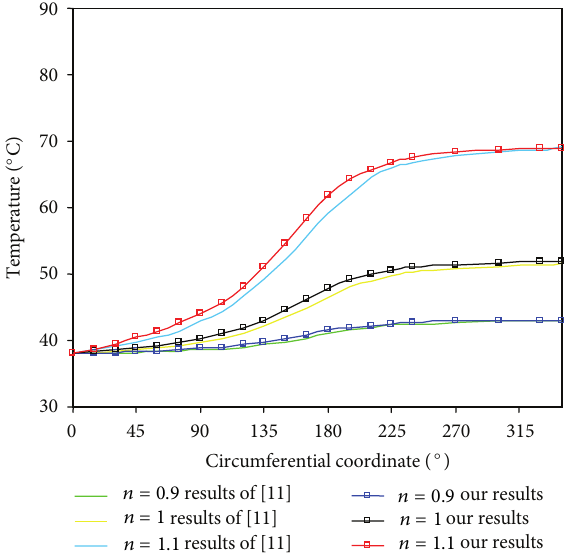
Figure 16: Evolution of the bearing internal surface temperature according to the circumferential coordinate at the central plan of the journal bearing and for different values of 𝑛 .